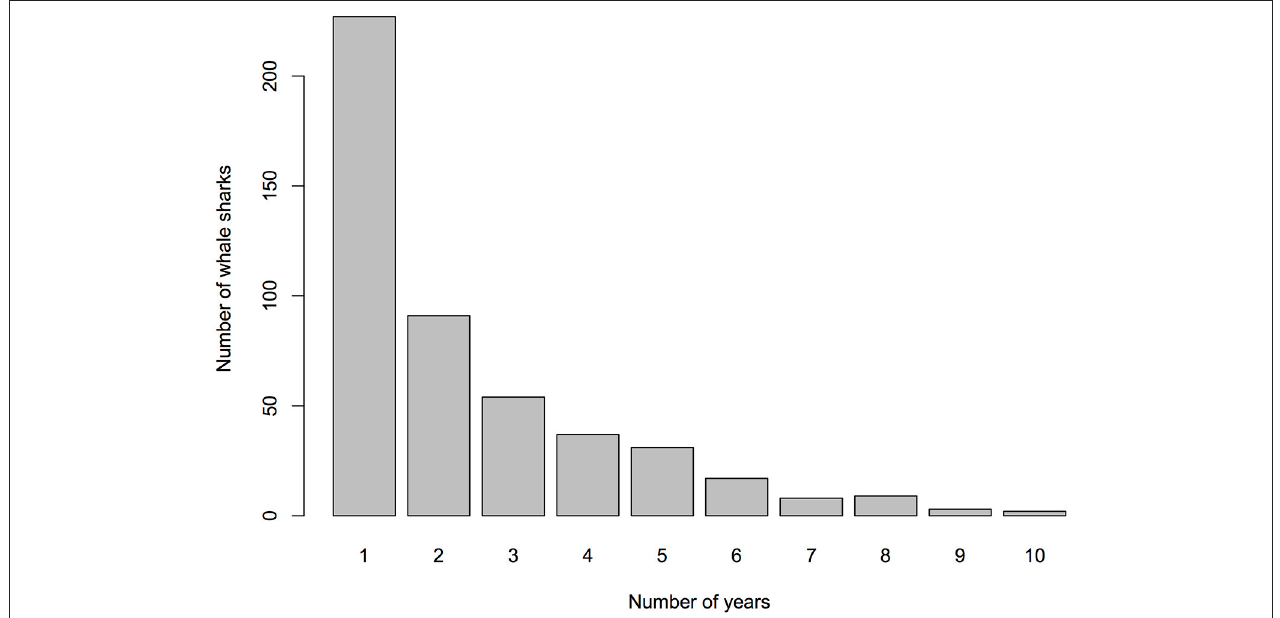
FIGURE 4 | Boxplot depicting the number of individual whale sharks sighted monthly at Donsol from 2007 to 2016.